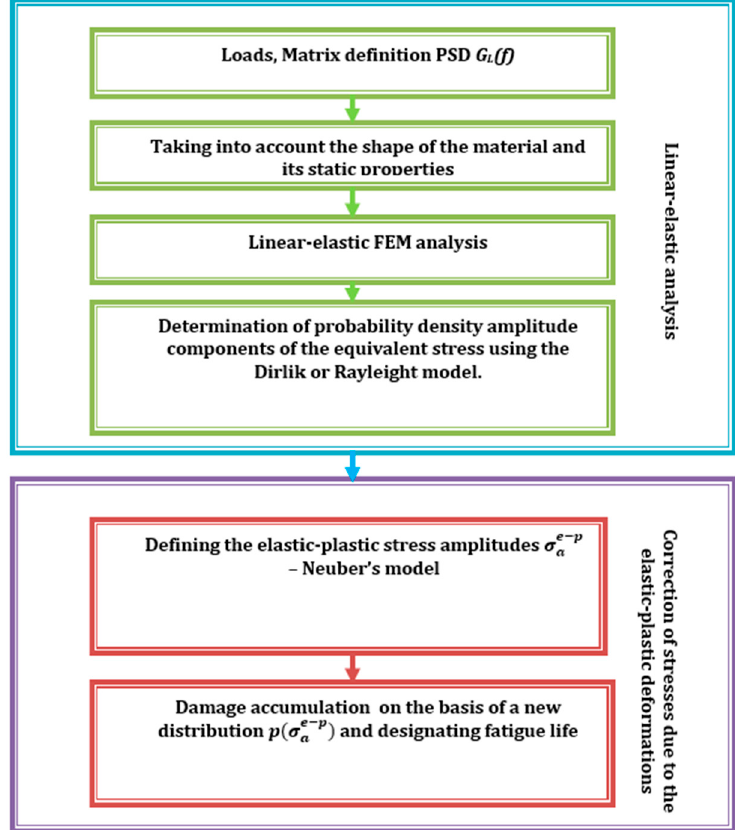
Figure 1. Calculation algorithm for determining fatigue life using the spectral method and stress correction due to elastoplastic deformation.